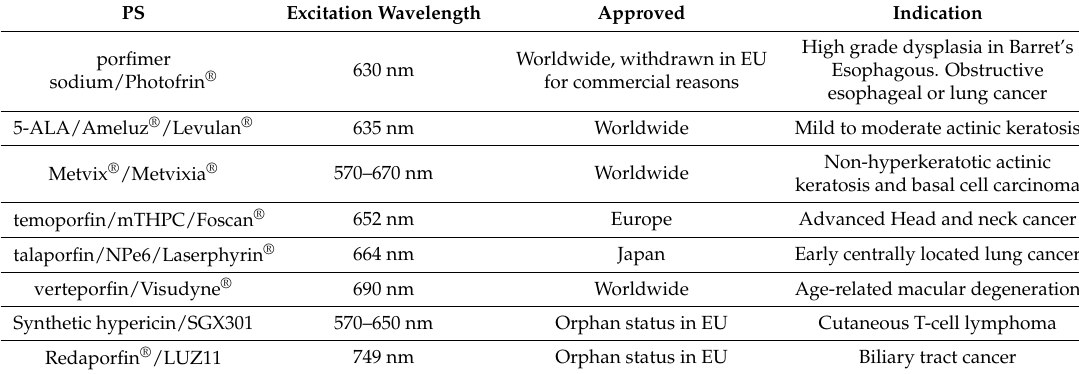
Table 1. Overview of clinically approved